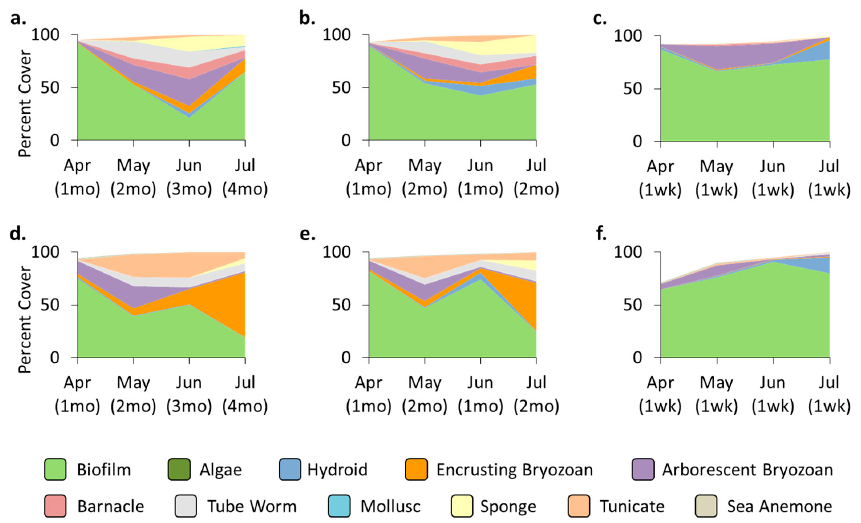
Figure 3. Fouling community structure on IS700 at Sebastian ( a – c ) and Port Canaveral ( d – f ). The first column ( a , d ) are the uncleaned panels, the second ( b , e ) are cleaned, and the third ( c , f ) are the groomed panels. The X-axis is the sampling month and the Y-axis is average percent cover. On IS900, fouling was lower and the similarity between sites higher than on IS700.